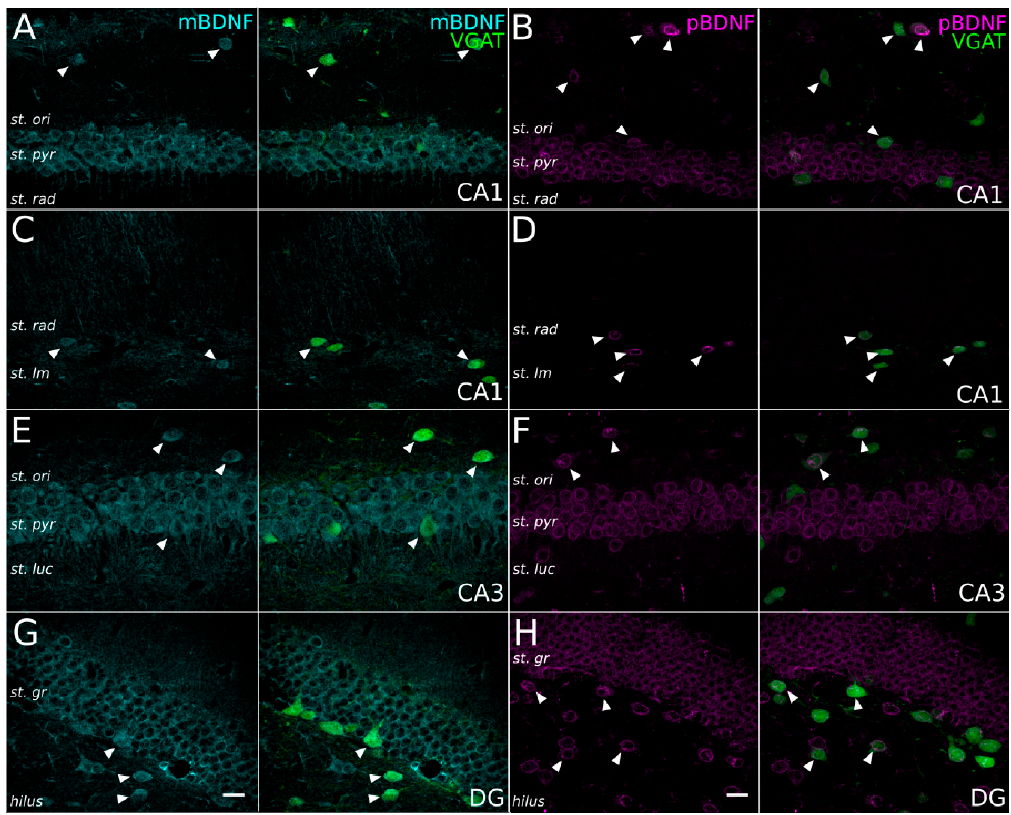
Figure 4. Expression of mBDNF and proBDNF in GABAergic cells in the main hippocampal areas.